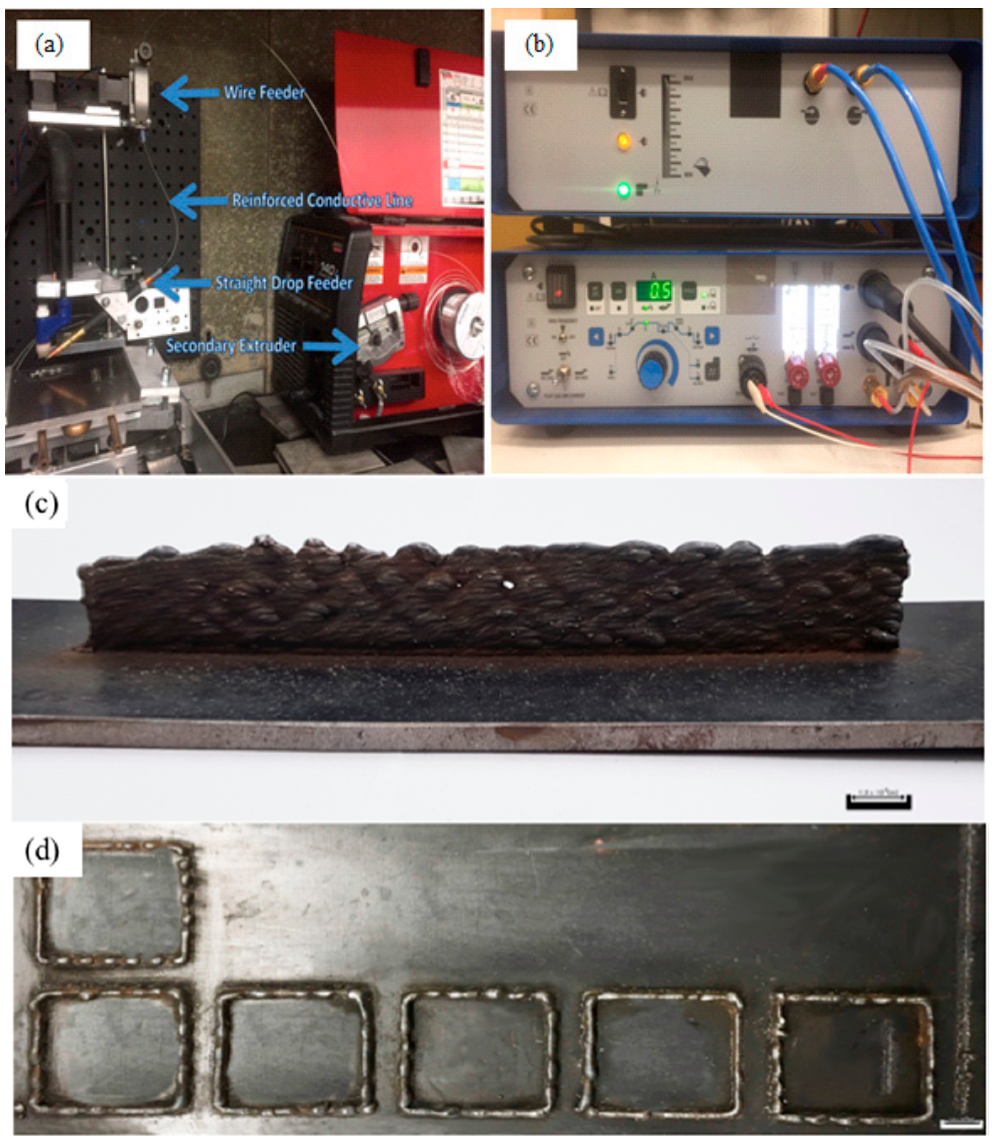
Figure 1. Experimental setup: ( a ) Overall system for WAAM; ( b ) pro-Fusion Dual Arc 82HFP welding machine used a power supply; ( c , d ) stainless steel produced by WAAM (scale bar represents 1 cm).